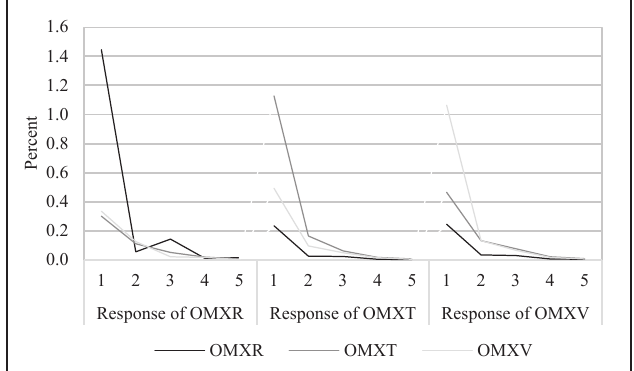
Fig. 2. Response of the Baltic stock indices to generalized one S. D. innovations (the author’s calculation).